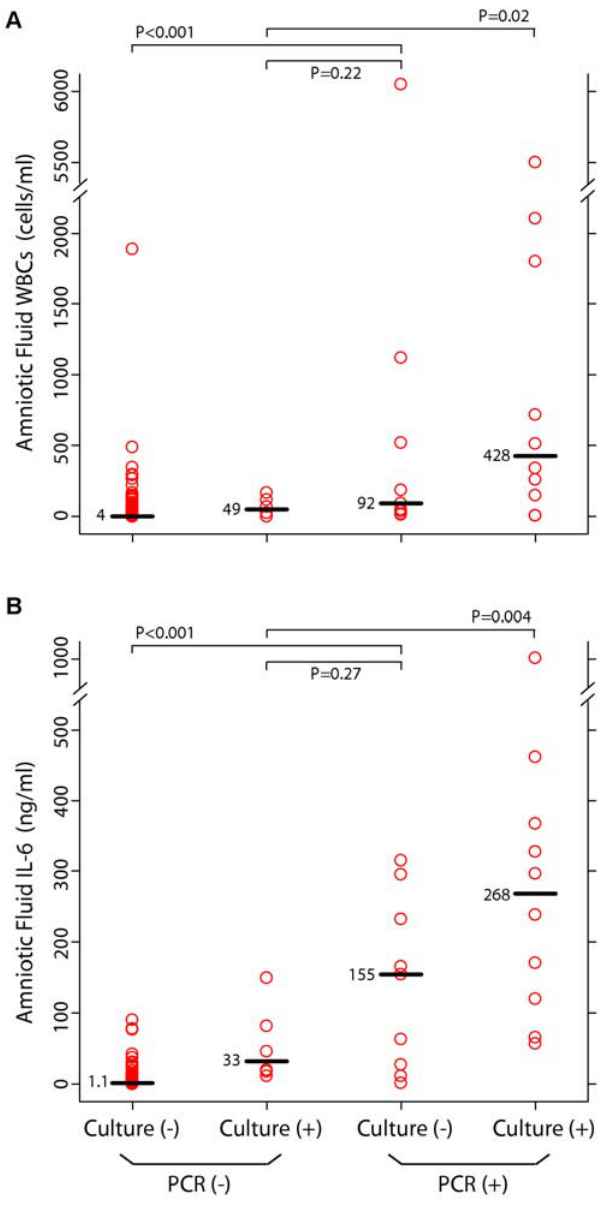
Figure 3. Correlation of PCR and Culture Results with Markers of Infection in Amniotic Fluid. Amniotic fluid concentrations of white blood cells (WBCs) (Panel A) and interleukin-6 (IL-6) (Panel B) as a function of PCR and culture results. Each circle represents one subject; each horizontal bar and adjacent number indicates the median value for that group. P values were calculated by means of the Mann-Whitney U test. PCR refers to end-point PCR for bacteria, fungi and archaea. Culture refers to the use of routine cultivation methods for bacteria (aerobic, anaerobic and genital mycoplasmas) and fungi. doi:10.1371/journal.pone.0003056.g003 with funisitis. Table 1 summarizes results from simple and multiple logistic regression modeling. After controlling for other covariates exhibiting statistically significant associations (see Table 1), the adjusted ORs of PCR and of culture for histological chorioam- nionitis were 20 (95% CI, 2.4 to 172) and 8.6 (95% CI, 1.0 to 76), respectively; the adjusted ORs of PCR and of culture for funisitis were 18 (95% CI, 3.1 to 99) and 5.8 (95% CI, 1.1 to 32), respectively.